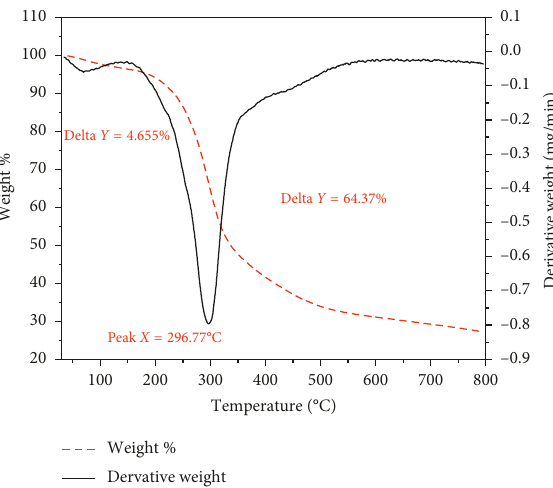
Figure 9: TGA analysis of the as-prepared RPP